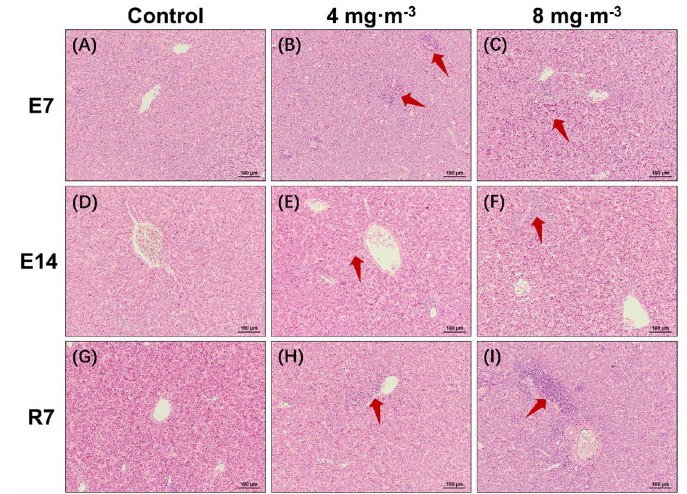
Figure 2. Effects of particulate matter exposure on liver histomorphology of broilers. Hematoxylin and eosin (H&E) staining of the liver. ( A , D , G ) represent the control group after E7, E14, and R7, respectively; ( B , E , H ) represent the exposure group at PM concentration of 4 mg·m −3 after E7, E14, and R7, respectively; ( C , F , I ) represent the exposure group at PM concentration of 8 mg·m −3 after E7, E14, and R7, respectively. Arrows indicate inflammatory cell infiltration. E7, exposure for 7 days; E14, exposure for 14 days; R7, recovery for 7 days.